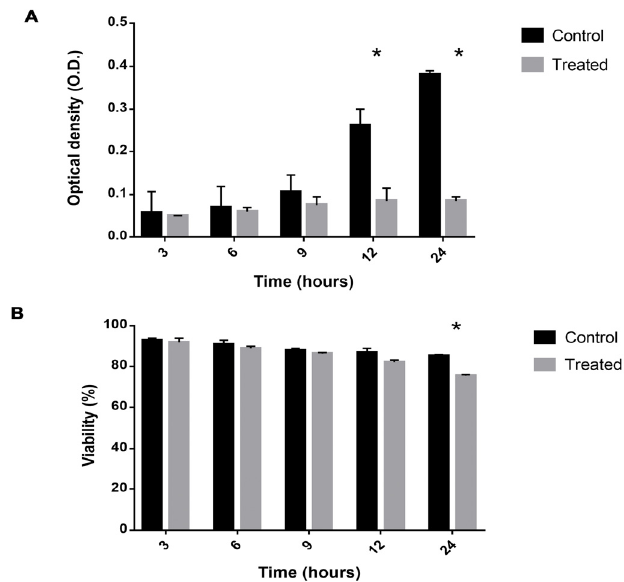
Figure 1. Viability and growth of P. brasiliensis cells exposed to mebendazole. ( A ) Viability of P. brasiliensis cells verified by counting using trypan blue. ( B ) Cell growth verified by optical density. The * represents a significant difference between the samples ( p ≤ 0.05). The error bar represents the deviation between the biological